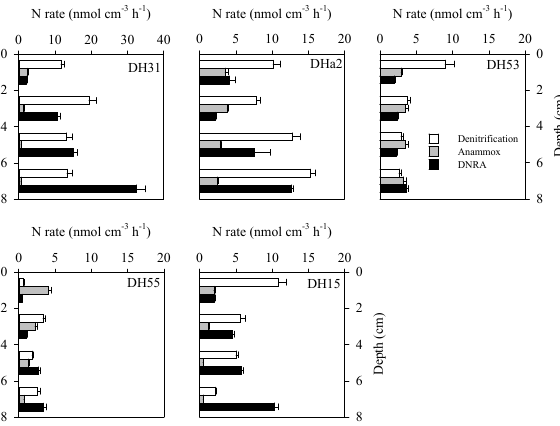
Fig. 5. Vertical distributions of potential denitrification (white bar), anammox (grey bar) and DNRA (black bar) rates in sediment of the ECS from the slurry incubation. The error bar (±1 SE) was calculated from the linear slope standard deviation given by the regression statistic.